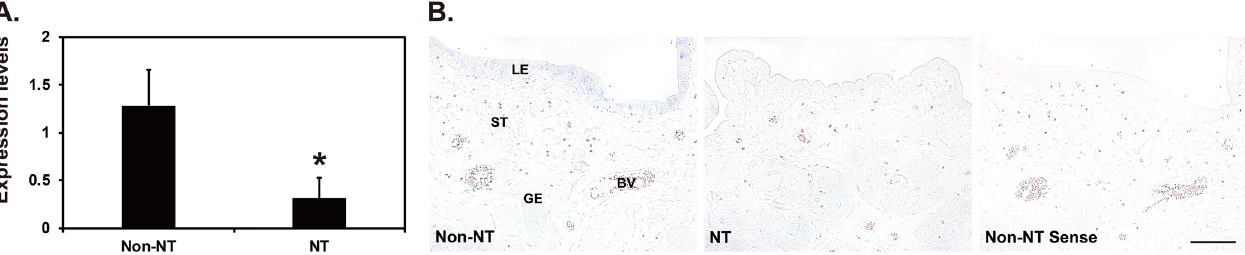
Figure 5. Expression of serum amyloid A3 ( SAA3 ) mRNA in the endometria of gilts carrying conceptuses derived from natural mating (Non-NT) or somatic cell nuclear transfer-cloned conceptuses (NT) on day 12 of pregnancy. (A) Real-time reverse transcription-polymerase chain reaction analysis of SAA3 mRNA in endometrial tissues from Non-NT and NT pregnancies. Data are reported as expression relative to that detected on day 12 of a Non-NT pregnancy after normalization of the transcript amount to the endogenous ribosomal protein L7 control. Data are presented as mean with standard error. * p<0.05. (B). In situ hybridization analysis of SAA3 mRNA in endometrial tissues from Non-NT and NT pregnancies. A representative uterine section from a Non-NT pig on day 12 of pregnancy hybridized with a digoxigenin-labeled sense SAA3 cRNA probe (Sense) is shown as a negative control for in situ hybridization. LE, luminal epithelia; GE, glandular epithelia; St, stroma; BV, blood vessel. Bar = 100